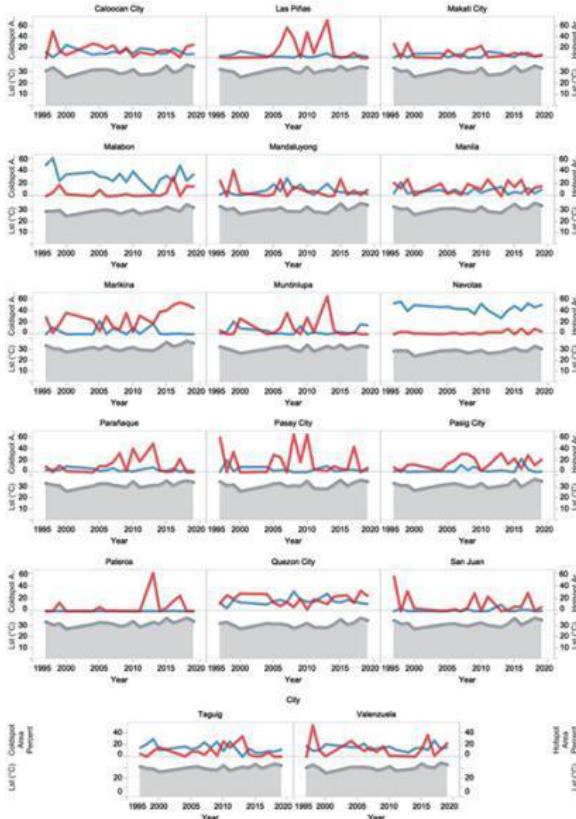
Figure 11. Time series plots of LST per city superimposed with cluster area percentages (cluster area divided by city area) for Metro